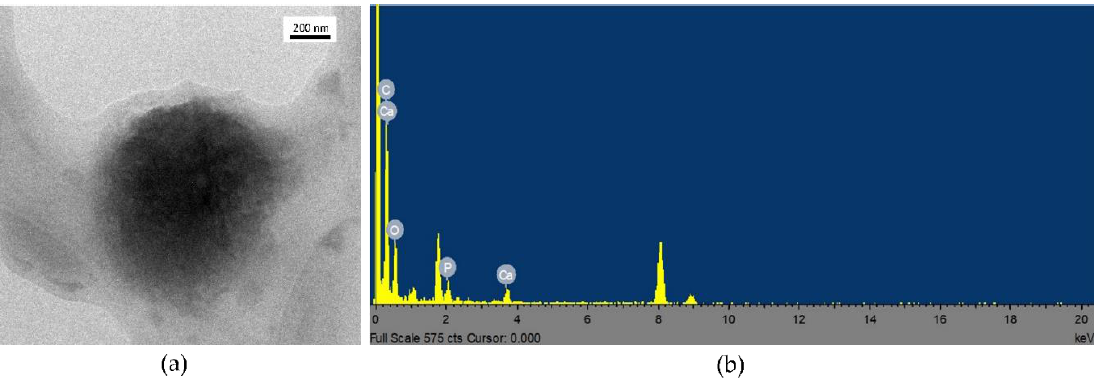
Figure 5. TEM image of ( a ) CaP-NP NEG 1B and ( b ) EDS spectrum of the region displayed in ( a ). The peaks around 8 KeV are due to the presence of Cu in the grid. Instrumental magnification: 15,000×.